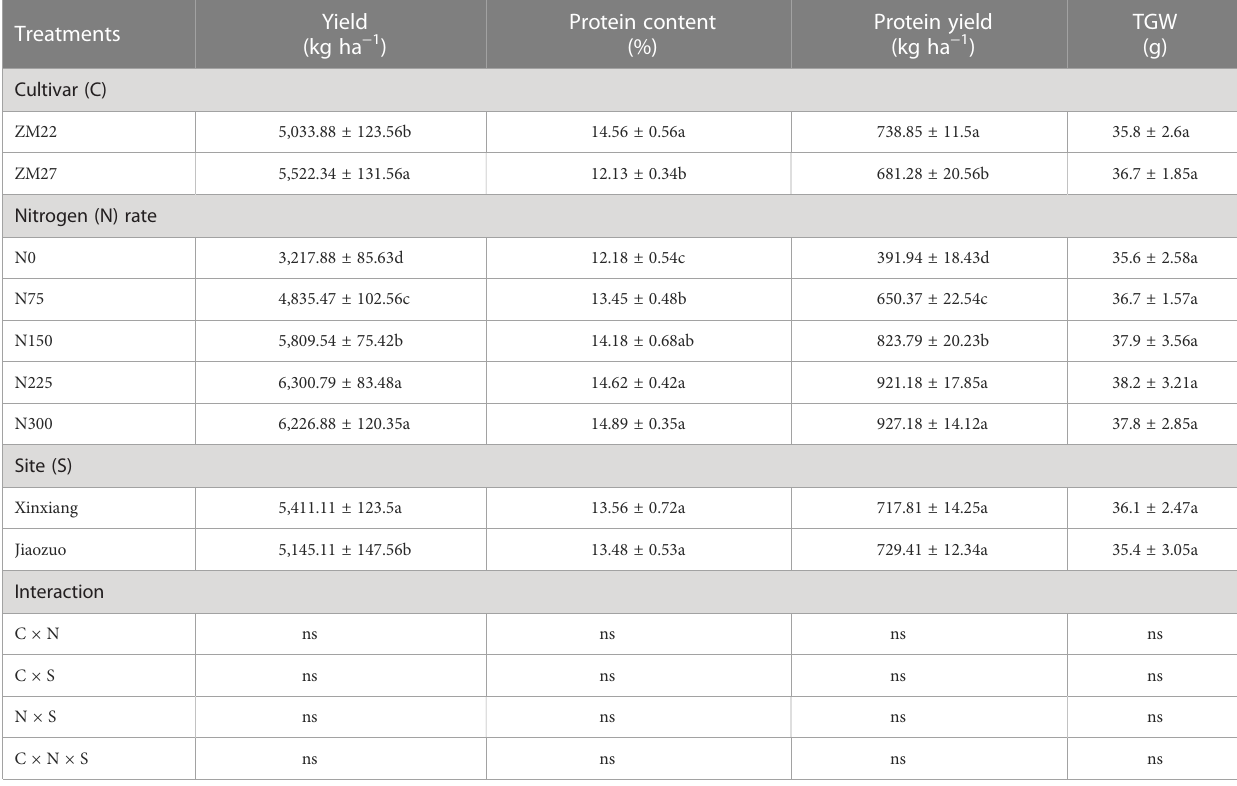
TABLE 2 Mean values of yield, protein content, protein yield, and a thousand grain weight (TGW) of two cultivars under fi ve N levels during the 2016 – 2017 growing seasons.